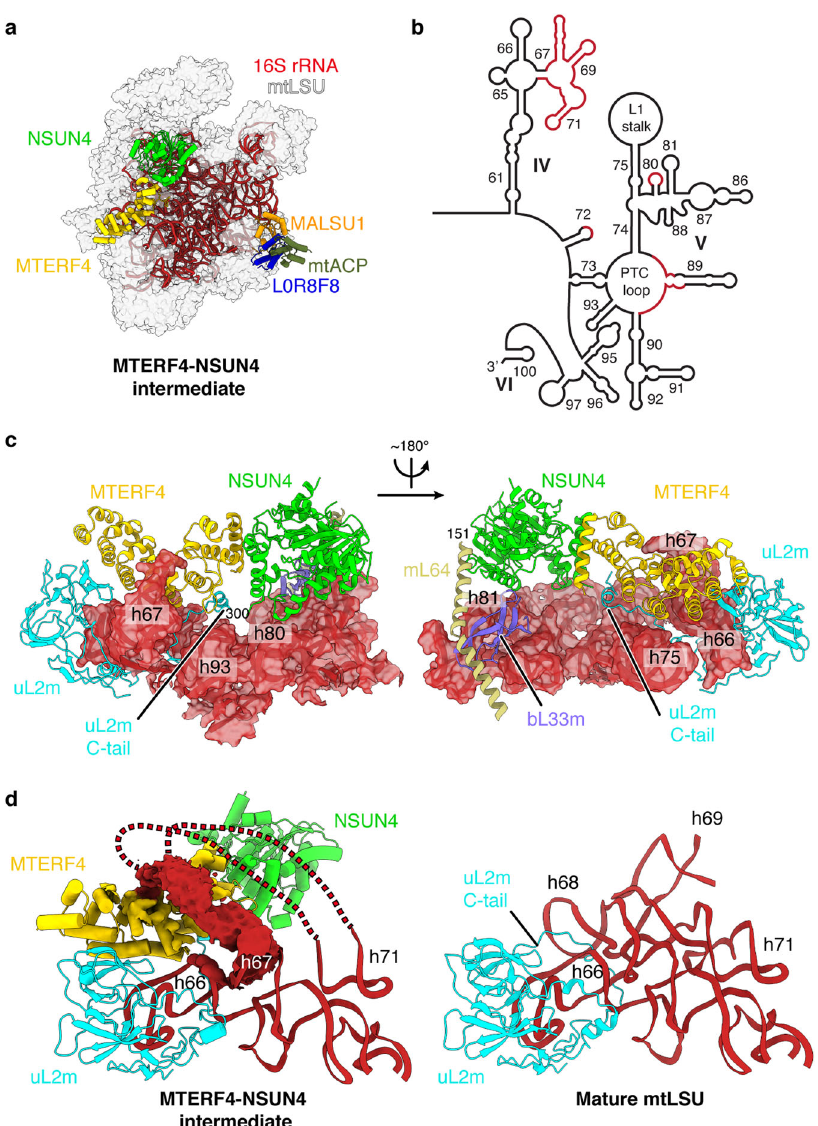
Fig. 1 Structure of the MTERF4-NSUN4-bound mtLSU assembly intermediate. a Cryo-EM structure of the MTERF4-NSUN4-bound large mitoribosomal subunit (mtLSU) intermediate (dataset 1). The 16S rRNA (red) and indicated biogenesis factors are shown as cartoon and the remaining mitoribosomal proteins (MRPs) are shown as gray transparent surface. NSUN4: lime green, MTERF4: yellow, MALSU1: orange, mtACP: olive, L0R8F8: blue. b Schematic depiction of the mature 16S rRNA secondary structure with domains IV – VI as indicated. Regions with distinct fold in the MTERF4-NSUN4 intermediate are depicted in red. c Interaction of the MTERF4-NSUN4 complex with the mtLSU. Regions of the 16S rRNA interacting with MTERF4-NSUN4 are shown as cartoon and as transparent surface. MTERF4, NSUN4, uL2m, bL33m, and mL64 are shown in cartoon representation. Coloring as in a and as follows: uL2m: cyan, bL33m: violet, mL64: sand. d (Left) In the MTERF4-NSUN4 assembly intermediate, the 16S rRNA region encompassing h68 – h71 wraps above MTERF4, as indicated by red lines. The density is shown as red surface. (Right) Closeup view of the 16S rRNA region 2469 – 2659 in the mature mtLSU (PDB 3J7Y) 3 . The fold observed in the mature mtLSU would clash with